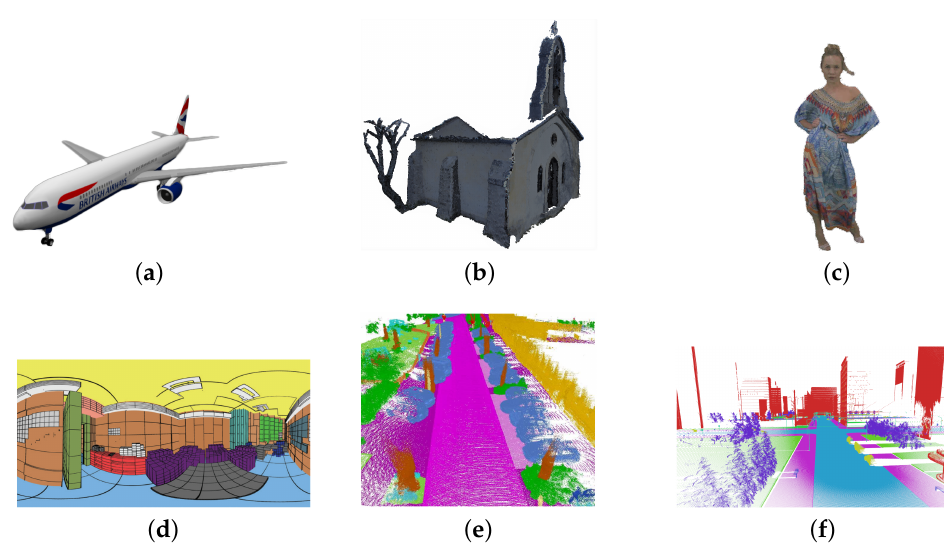
Figure 3. Samples from some of the presented datasets. ( a ) ShapeNet, ( b ) MPEG, ( c ) 8iVFB, ( d ) S3DIS, ( e ) SemanticKITTI, ( f )